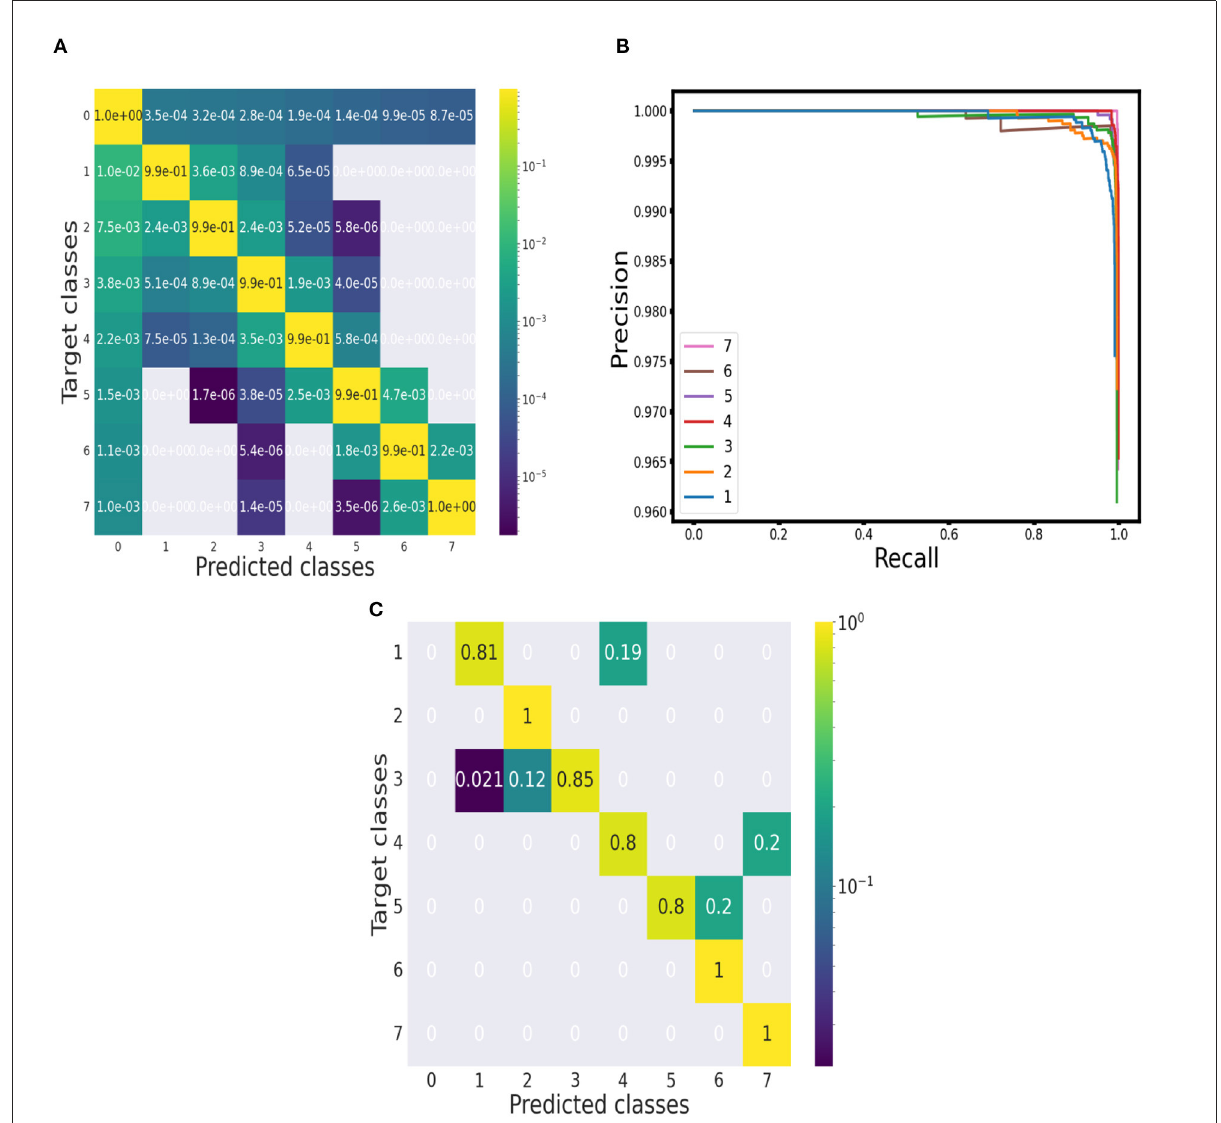
FIGURE3 Evaluation of performance. (A) Point-wise approach: Confusion matrix of the performance on synthetic spectra. (B) Object-wise approach: Precision-recall curves for each multiplet class (baseline class excluded) at threshold 75 % . (C) Point-wise approach: Confusion matrix of the performance on the 10 1 H NMR spectra of the testing